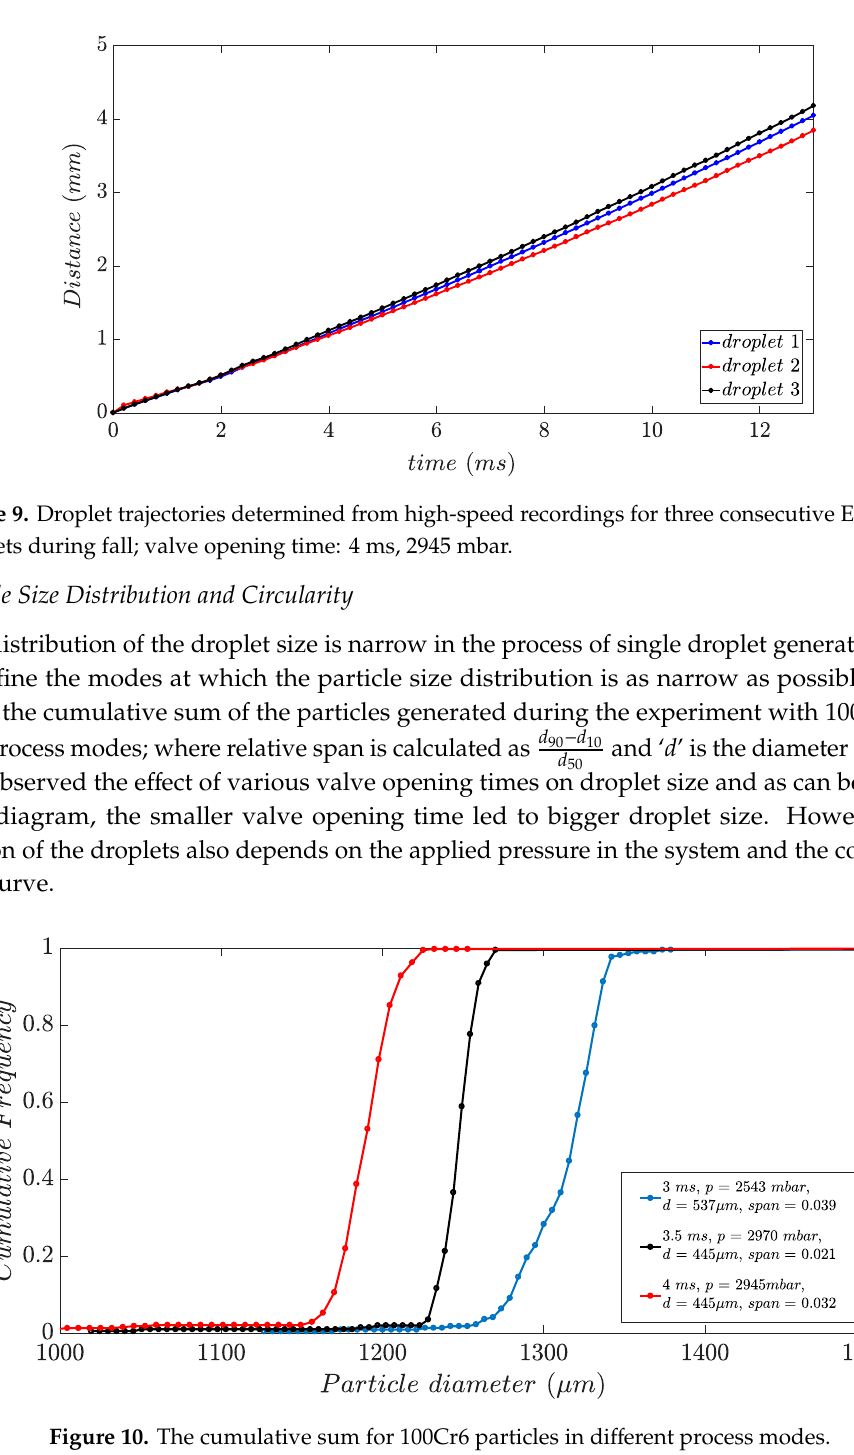
Figure 10. The cumulative sum for 100Cr6 particles in different process modes.